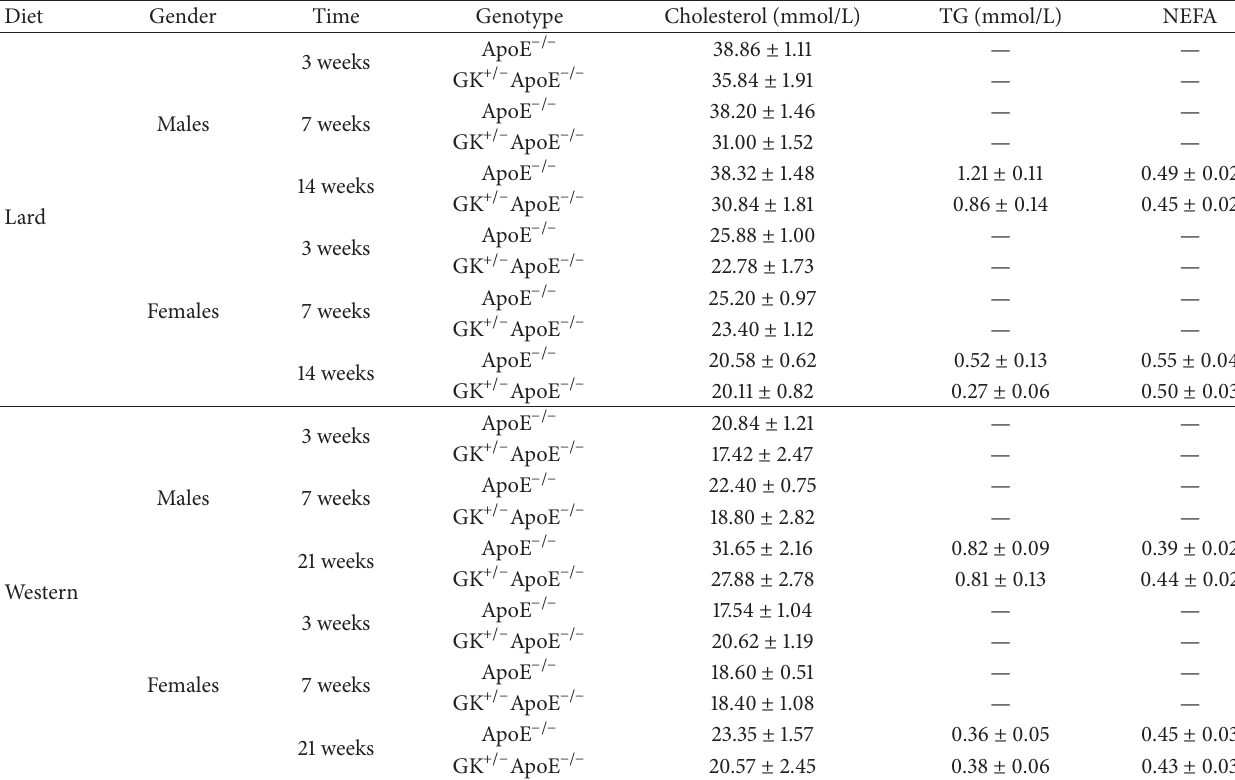
Table 1: Lipid levels in GK +/− ApoE −/− and ApoE −/− mice on Lard and Western diet measured in the atheroprogression study. Diet